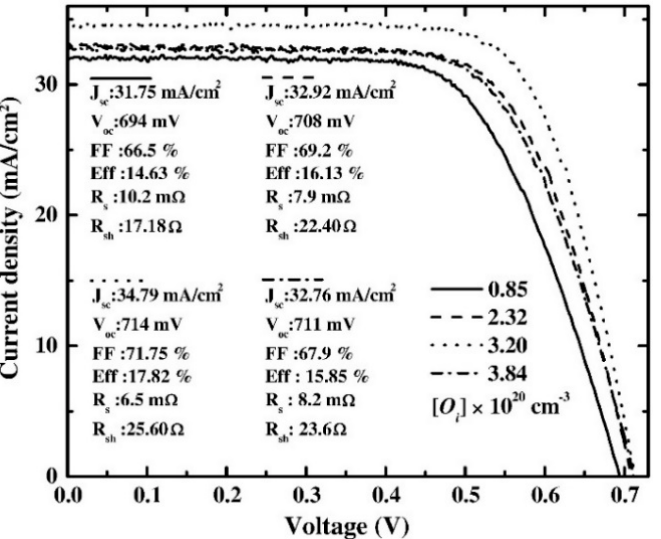
Figure 3. The light–CV characteristic for SHJ SCs and the influence of the diverse densities of [Oi] on the various SC parameters (reprinted with permission from ref. [67]; copyright form Elsevier order number 5492911003623).